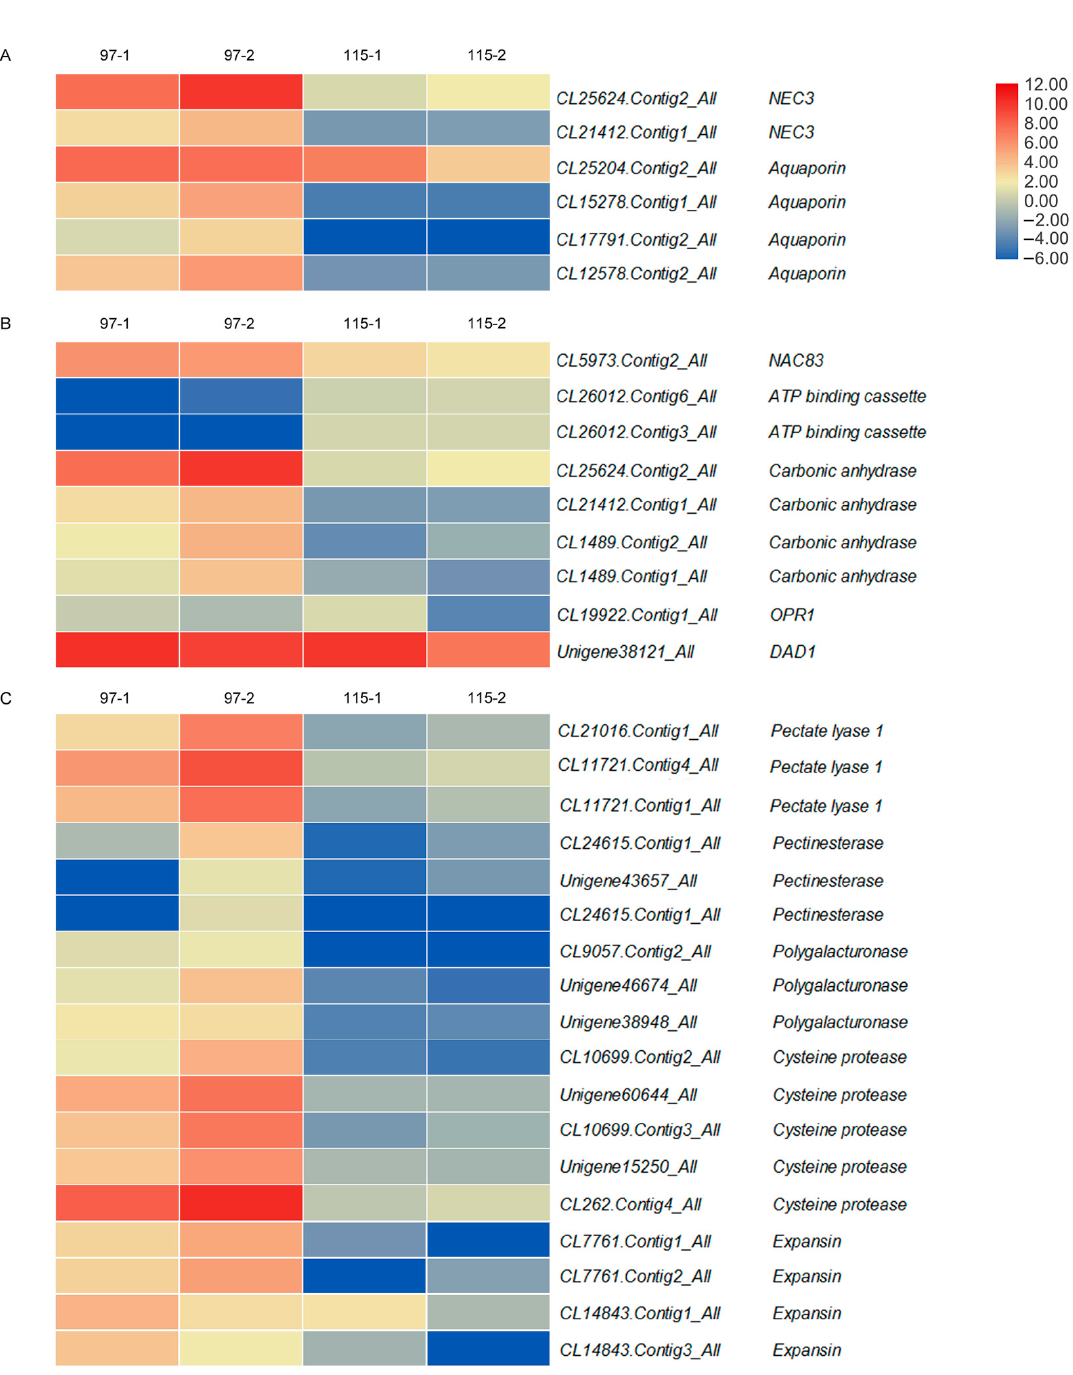
Figure 4. Heatmap of differentially expressed genes (DEGs) potentially involved in anther dehydration, lignin deposition, and stomium region degradation in chrysanthemum cultivars ‘Qx-097 ′ and ‘Qx-115 ′ . 97-1, anthers of ‘Qx-097 ′ at period 1; 97-2, anthers of ‘Qx-097 ′ at period 2; 115-1, anthers of ‘Qx-115 ′ at period 1; 115-2, anthers of ‘Qx-115 ′ at period 2. The bar represents the expression (FPKM) level of each gene in 97-1, 97-2, 115-1, and 115-2 as indicated by red/blue rectangles, the deeper color indicates the higher/lower expression. The number next to the color bar on the right side refers to the Log 2 value of the FPKM.